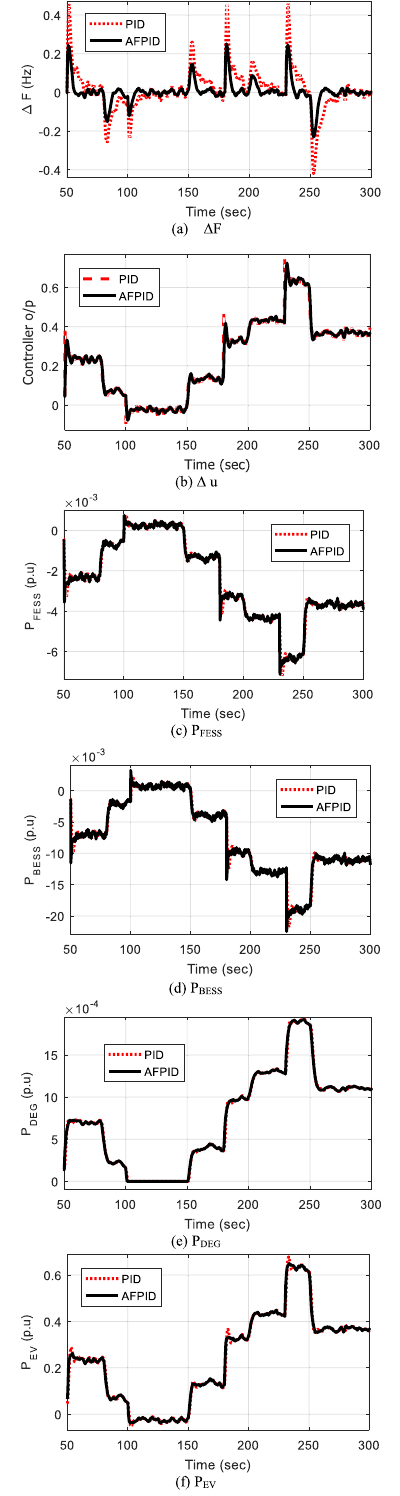
Fig. 12 System performance for case 3 a Δ F b Δ u c P FESS d P BESS e P DEG f P EV